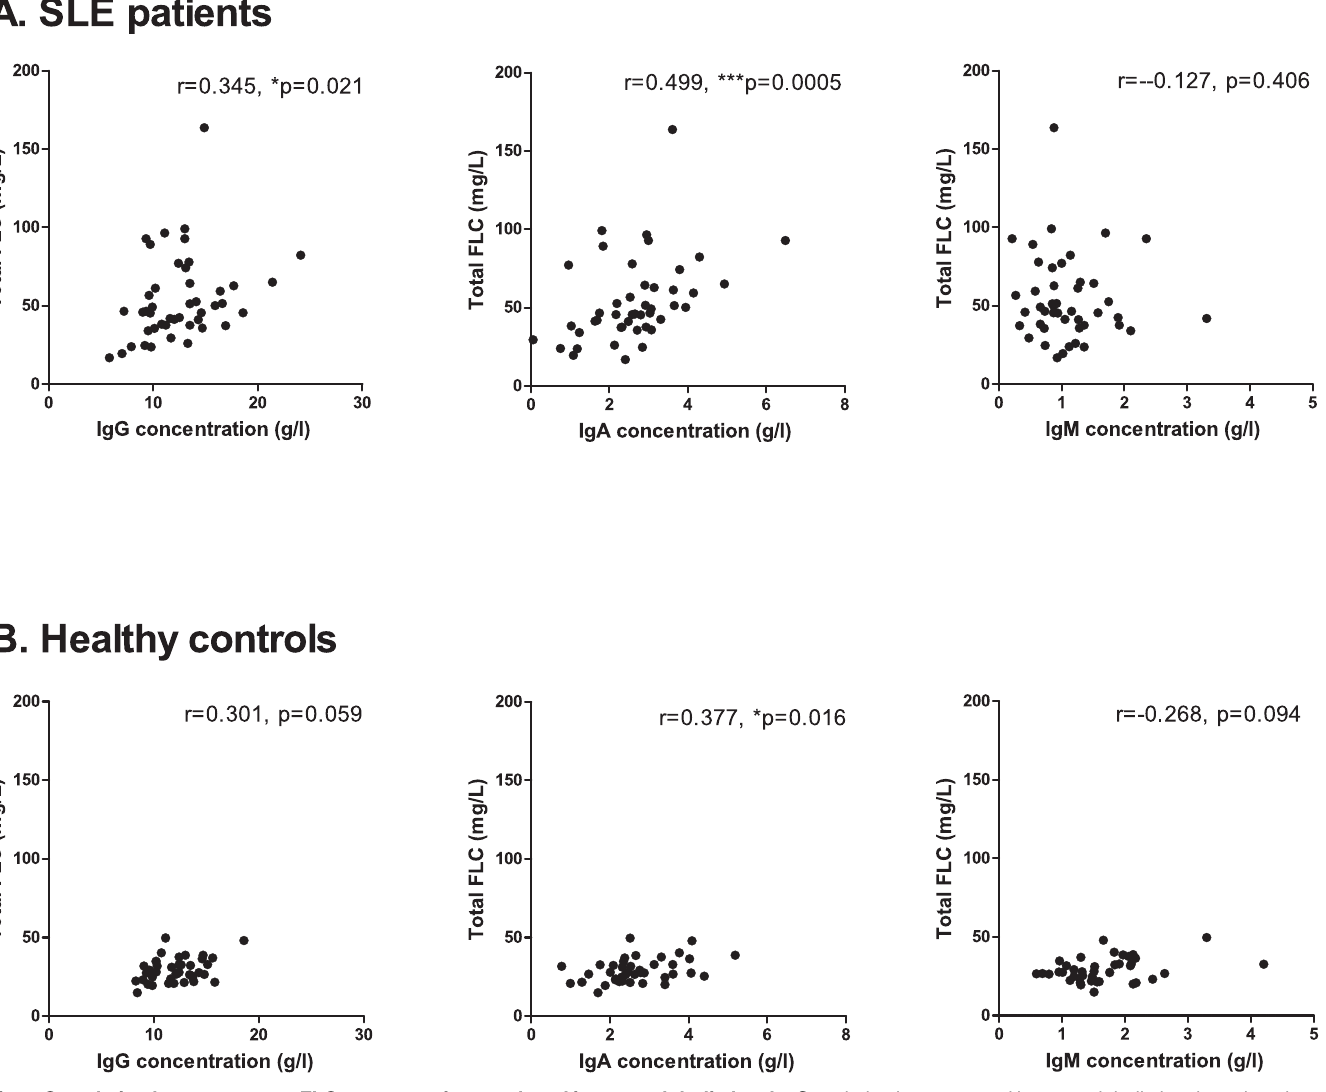
Fig 5. Correlation between serum FLC concentrations and total immunoglobulin levels. Correlation between total immunoglobulin levels and total FLC, λ FLC and κ FLC levels in SLE patients (A) (n = 45) and healthy controls (B) (n = 40) A: SLE patients . r-values are 0.345 (p = 0.021), 0.499 (p = 0.0005) and -0.127 (p = 0.406) regarding total FLC, λ FLC and κ FLC levels, respectively. B: Healthy controls . r-values are 0.301 (p = 0.059), 0.377 (p = 0.016) and -0.268 (p = 0.094) regarding total FLC, λ FLC and κ FLC levels, respectively. FLCs — free light chains, SLE — systemic lupus erythematosus.